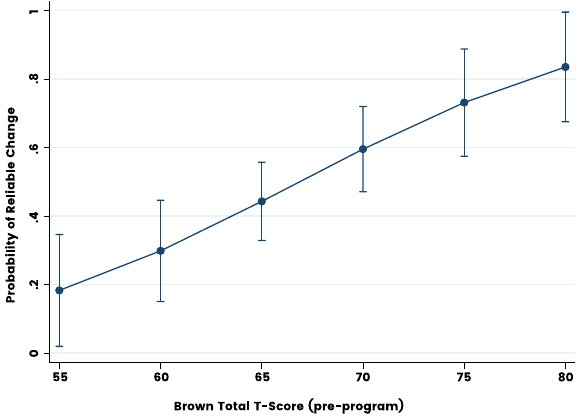
Fig. 3 Probability of observing reliable change based on Brown Attention- De fi cit Disorder Scales (BADDS) baseline scores. Baseline BADDS scores signi fi cantly predicted reliable change, such that a one-unit increase in baseline BADDS T-Score was associated with a 15% odds increase in reliable